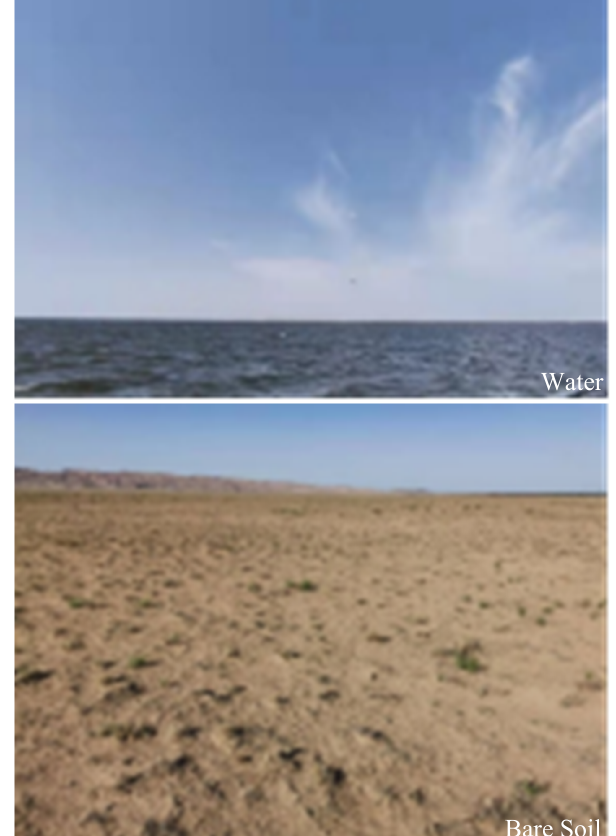
Figure 4. Images of water and bare soil in Ulansuhai Nur.